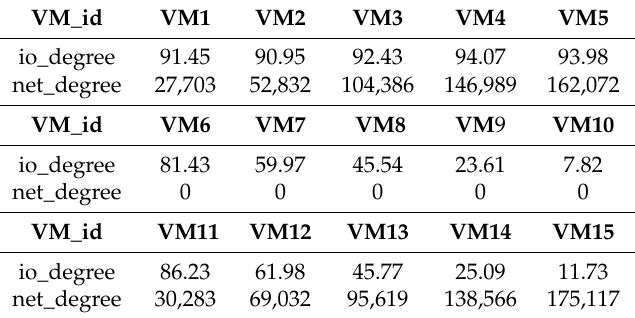
Table 2. CPU-intensive, network-intensive and mixed-load property values.